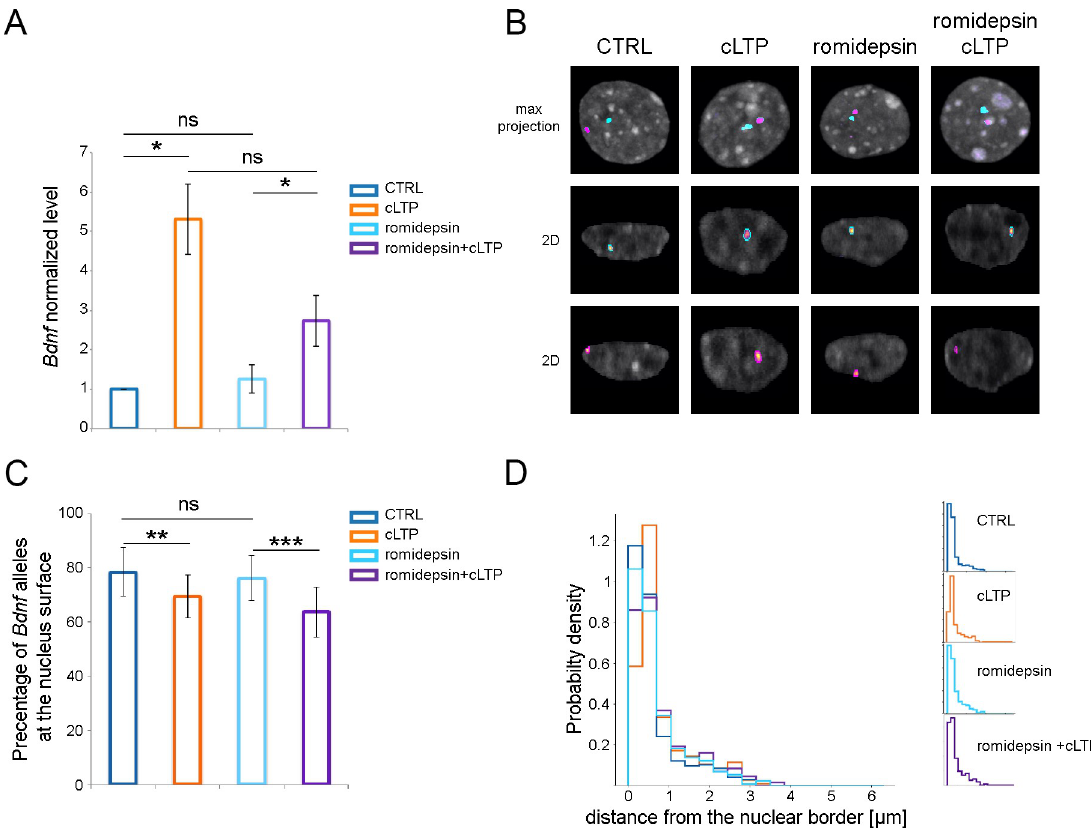
Fig 5. The inhibition of HDAC1/2 is not sufficient to induce Bdnf transcription and repositioning. (A) The graph shows the expression of Bdnf relative to Gapdh (normalized to control Bdnf level) in the hippocampal neurons incubated for 2 hours with DMSO vehicle (CTRL, blue bar) or picrotoxin, forskolin, and rolipram (cLTP, orange bar), incubated for 2 hours with 250 nM romidepsin and 2 hours with DMSO (romidepsin, light blue bar) or picrotoxin, forskolin, and rolipram (romidepsin+cLTP, violet bar). Kruskal-Wallis test for group comparison: p < 0.01, One-Sample t-test or Welch two sample t-test for pairwise comparison: � p < 0.05, ��� p < 0.001; error bars indicate standard error of the mean for 3 independent experiments (B) Representative picture of the nuclei of hippocampal neurons treated as described above. Hoechst 3342 staining for chromatin is shown in greyscale and segmentation of FISH signals for the Bdnf gene are shown in magenta and cyan. (C) Percentages of nuclei with the minimum distance between the respective alleles and nucleus surface < 350 nm are shown (Chi-square test, all groups, p < 0.0001; Fisher’s exact tests: �� p < 0.01, ��� p < 0.001, error bars indicate standard deviation of the binomial distribution). (D) Quantitative analysis of the intracellular positions of Bdnf alleles in the nuclei of hippocampal neurons treated and color-coded as in A. The minimal distance between the respective alleles and nucleus surface is presented in the normalized histogram.